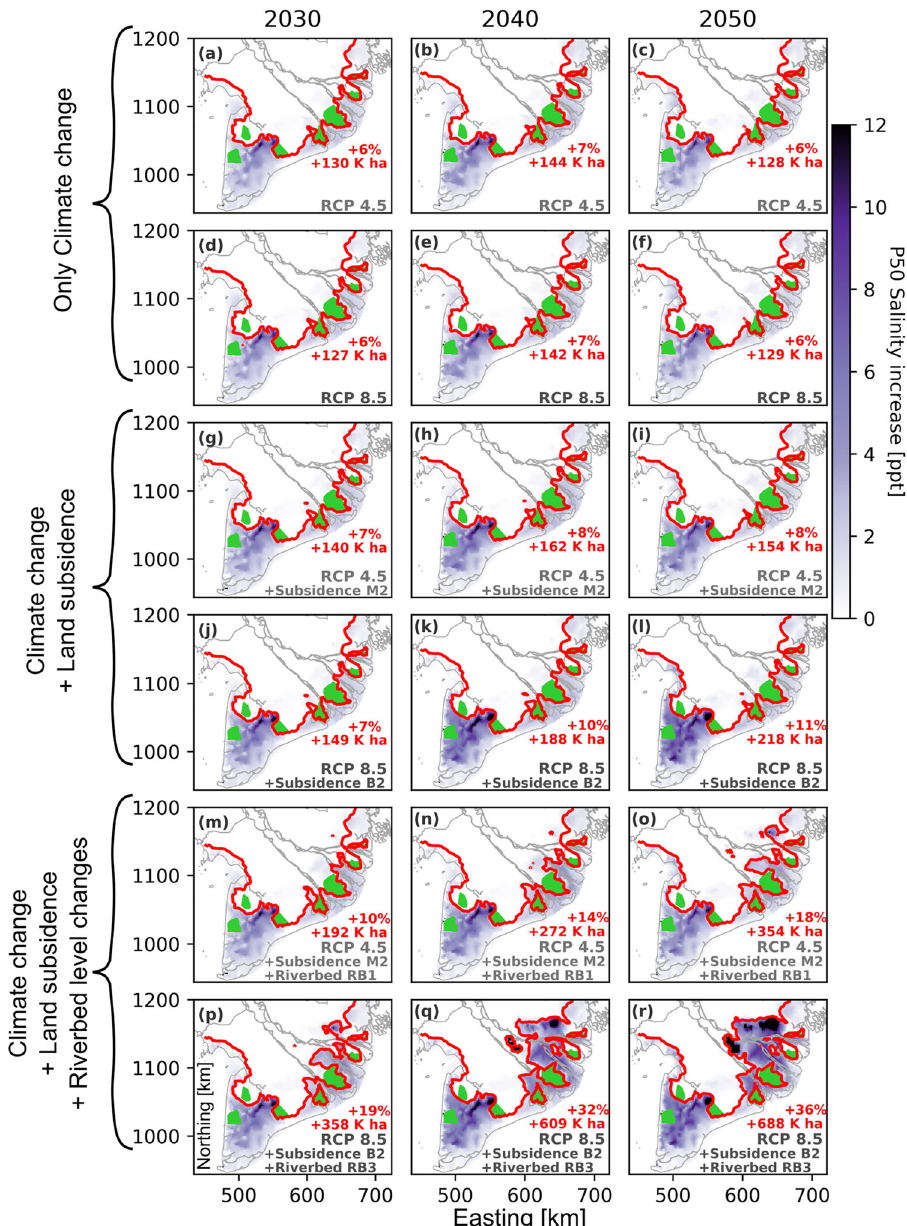
Fig. 3 Projections of salinity increase in the Mekong Delta under different scenarios. Spatial distribution of P50 (average) “ salinity increase ” and the extent of salt intrusion (2 PSU abolute salinity contour line) under RCP 4.5 (uneven rows) and RCP 8.5 (even rows) CC scenarios for CC scenario only ( a – f ); combined effect of CC and land subsidence ( g – l ); combined effect of CC, land subsidence and bed level incision ( m – r ); the green areas de fi ne the existing freshwater zones (mainly by sluicgates); the red percentage per panel is the increase in salinity-affected surface area relative to the present-day conditions and the red number in thoudand hectares [K ha] per panel shows increase in area affected by salt intrusion under that